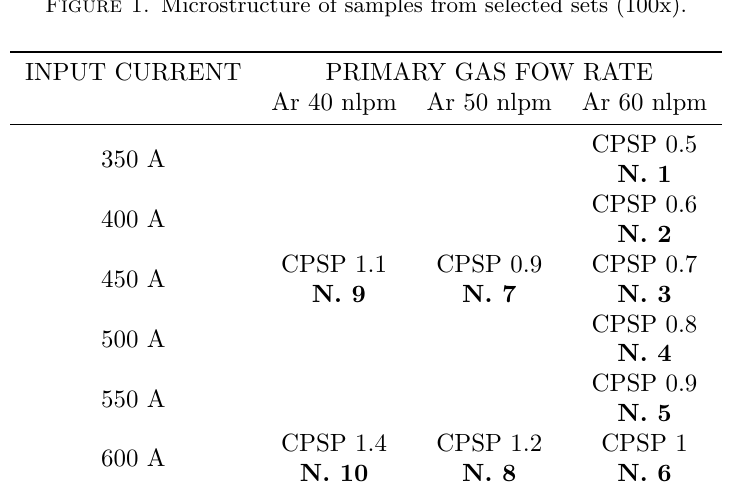
Figure 1. Microstructure of samples from selected sets (100x).